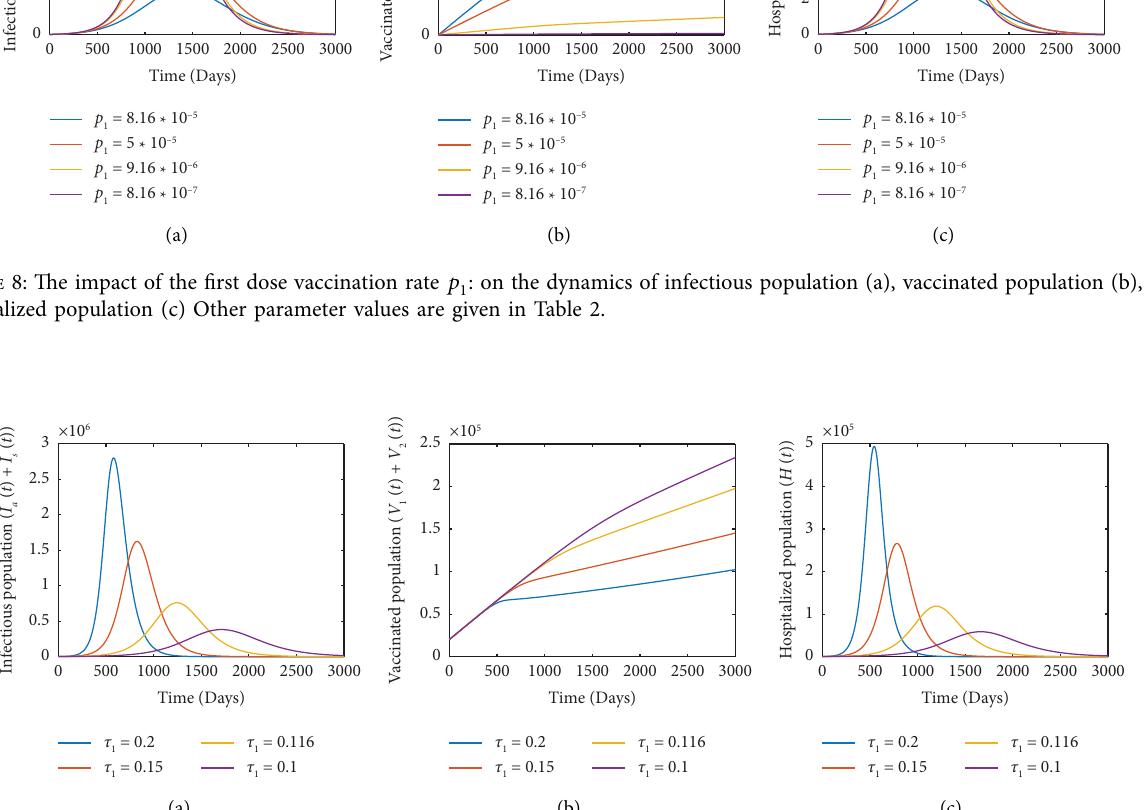
on the dynamics of infectious population, (a), total 1